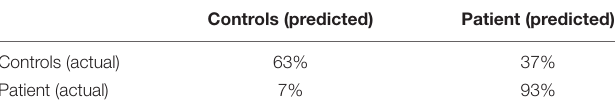
The result of the hyperparameter tuning for the SVM (linear) was a cost of 0.316. Cost represents the penalty given for misclassification: a higher cost allows less misclassification when drawing the decision